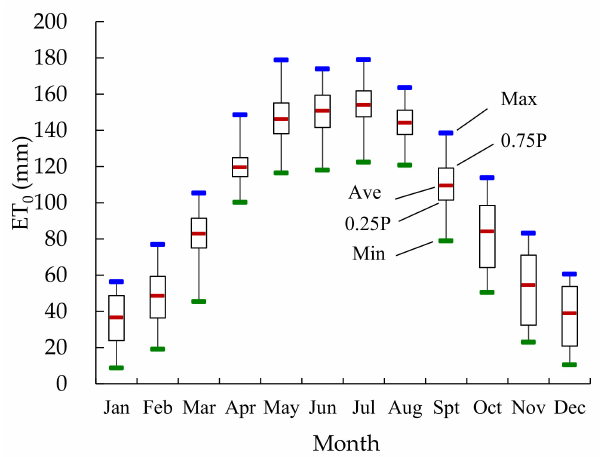
Figure 3. Monthly changes of ET 0 . Note: 0.25P represents the upper quartile and 0.75P represents the lower